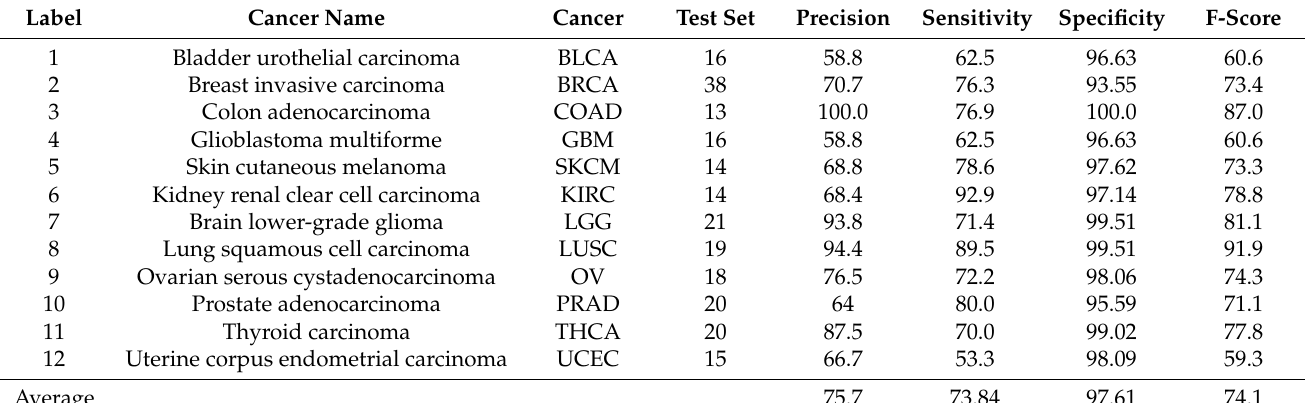
Table 2. Results of precision, sensitivity, specificity, and F-score for 12 cancers.